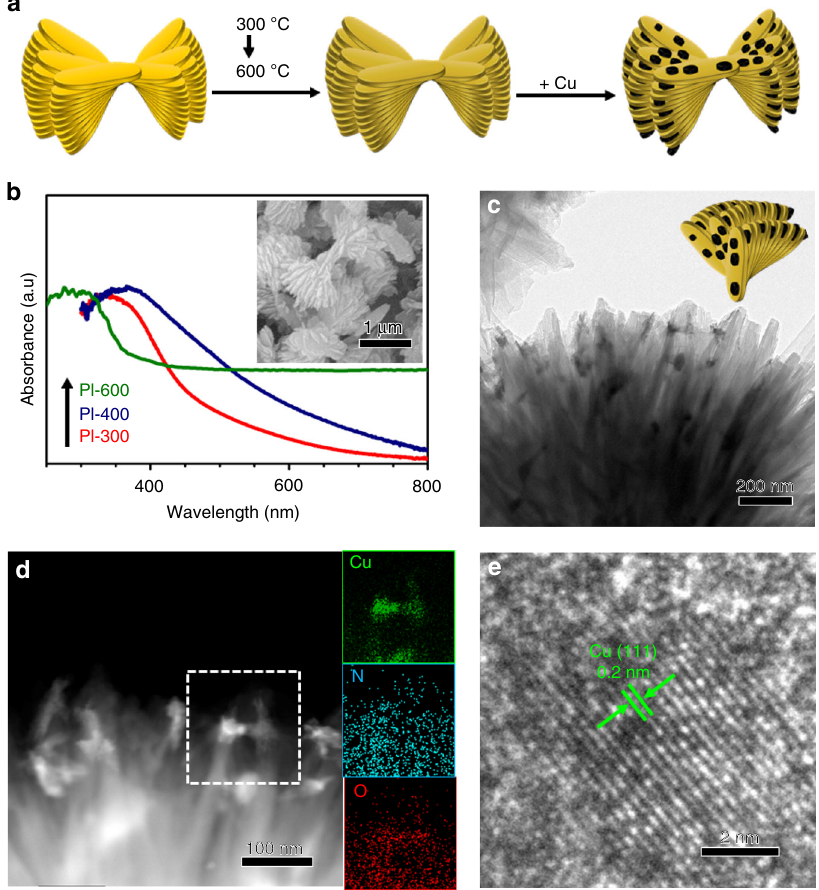
Fig. 1 Fabrication and structure of catalysts. a Synthetic procedure of typical Cu/PI catalyst. b Ultraviolet-visible (UV-vis) spectra of bare PI samples. Transmission electron microscopy (TEM) c , high-angle annular dark- fi eld (HAADF) d , and high-resolution TEM (HRTEM) e images of Cu/PI-300. Insets: b Scanning electron microscopy (SEM) image of PI-300; d Energy dispersive X-yay (EDX) mapping images of the selected